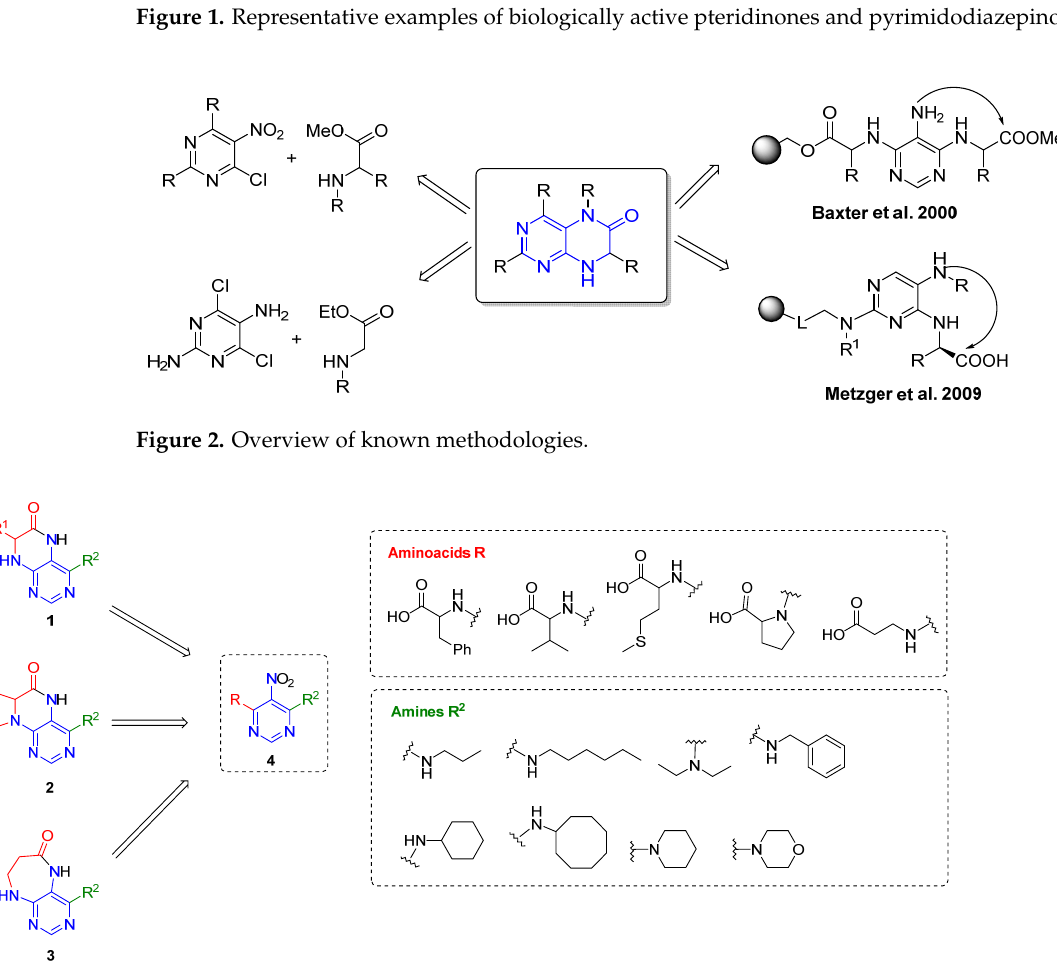
Figure 3. Overview of the target compounds and used building